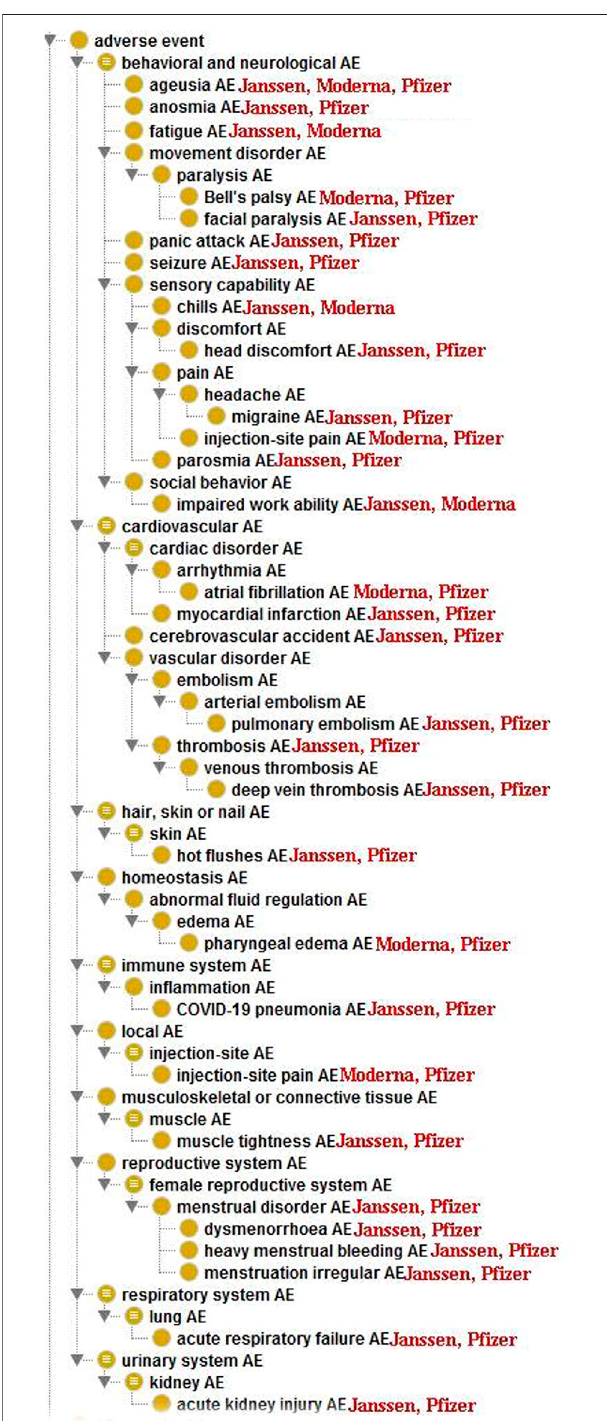
FIGURE 2 | Ontological classi fi cation of statistically signi fi cant AEs associated with at least 2 of the three COVID-19 vaccines using the Ontology of Adverse Events